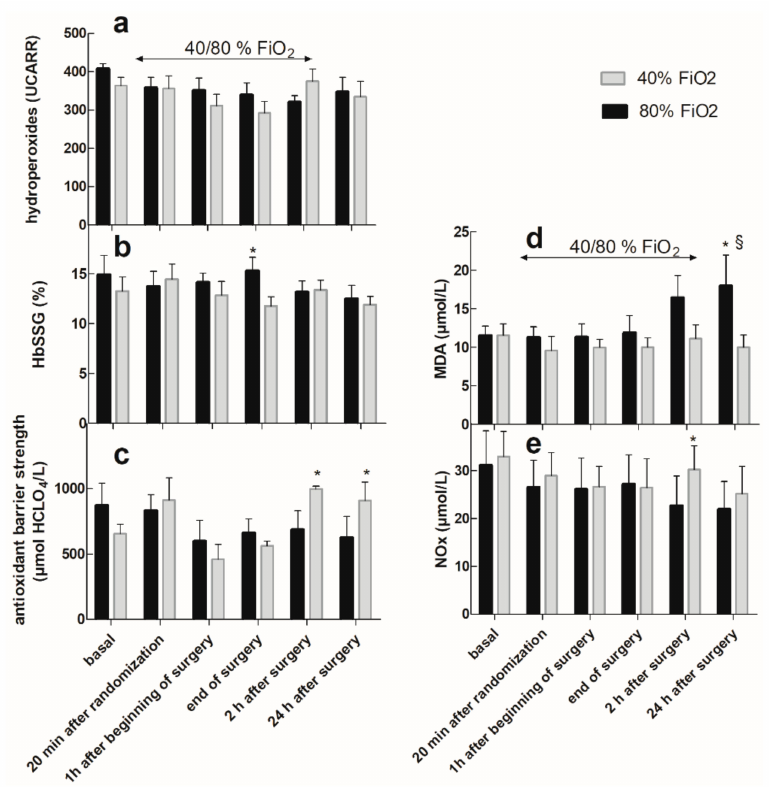
Figure 3. Oxidative stress markers: ( a ) hydroperoxides; ( b ) glutathionyl hemoglobin (HbSSG); ( c ) antioxidant barrier strength; ( d ) malondialdehyde (MDA); ( e ) Nitrites and nitrates (NO x ). Data are expressed as mean ± SEM. § p < 0.05 when compared to basal value (two-way ANOVA test, Dunnett’s